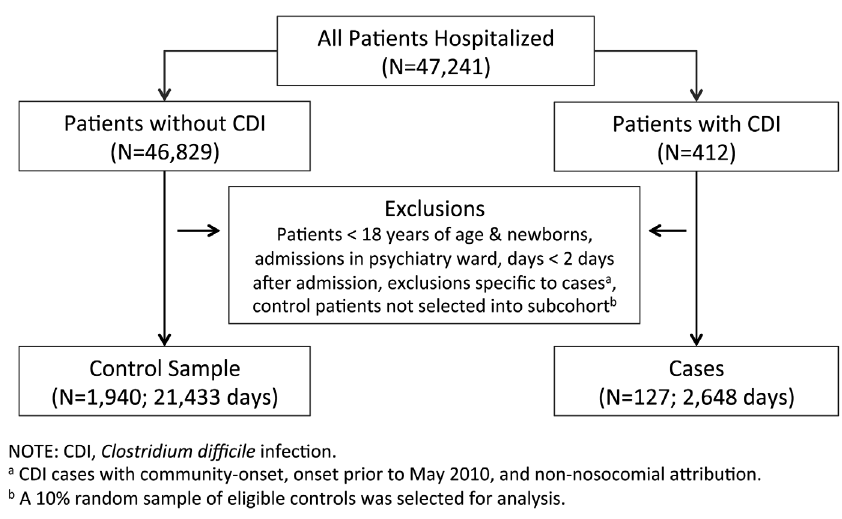
Figure 1. Patients and Patient-Time Included in the Final Cohort, Sunnybrook Hospital, Toronto, Canada, June 2010 to May 2012.